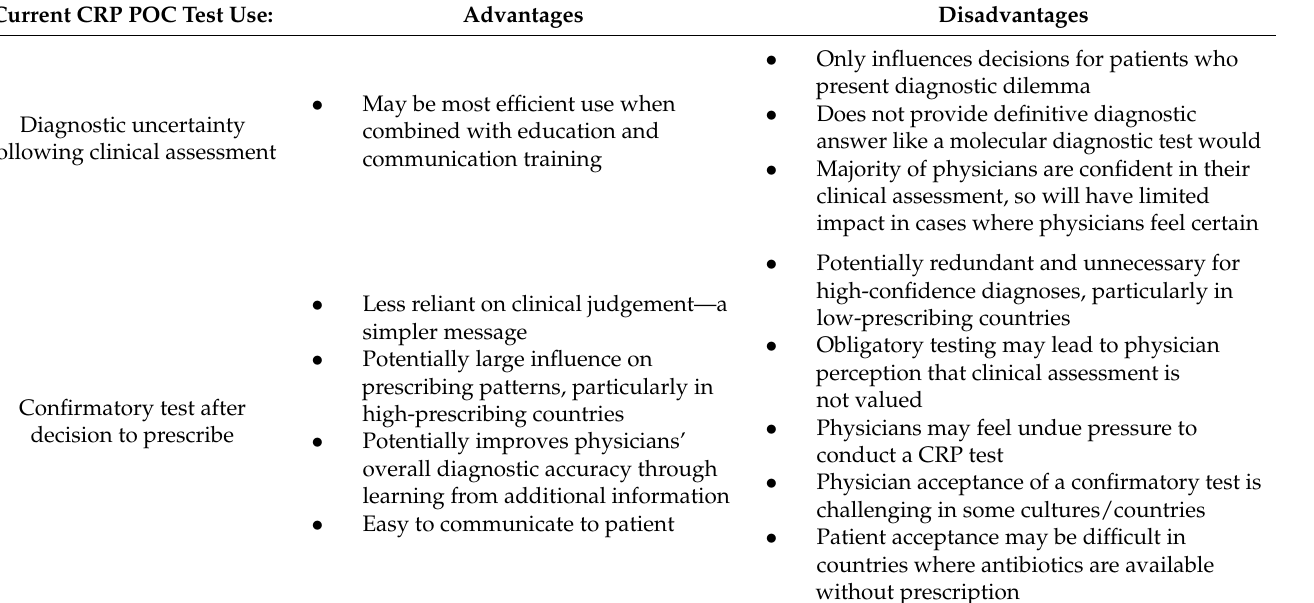
Table 2. The current primary care debate about CRP POC test